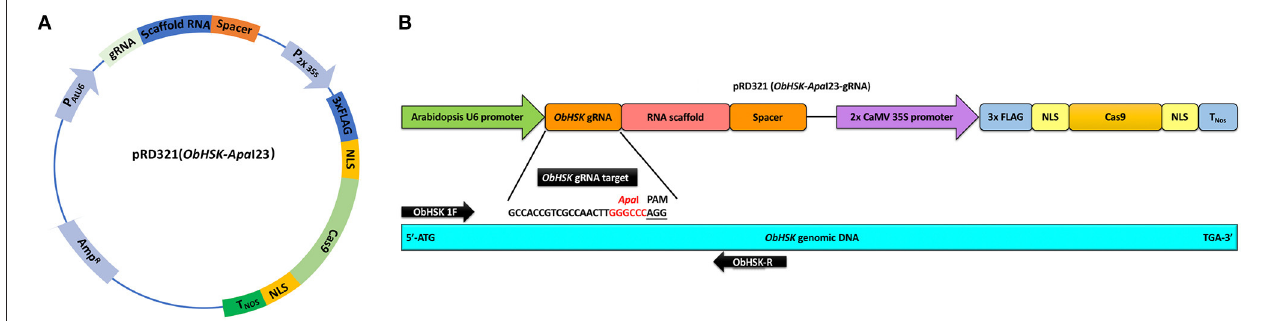
FIGURE 1 | (A) Transient ObHSK CRISPR-editing vector pRD321. Expression of ObHSK - Apa I23 gRNA and the scaffold RNA is driven by the Arabidopsis U6 promoter. The humanized Cas9 (hCas9) gene with 3X FLAG and nuclear localization signal (NLS) is under the control of the 2X CaMV 35S promoter and the nopaline synthase terminator (T Nos ). (B) The location of the ObHSK - Apa I23 gRNA target within the 5 ′ region of the ObHSK gDNA is indicated, together with the PCR primer set used to amplify the region containing and flanking the target site for mutant analysis.